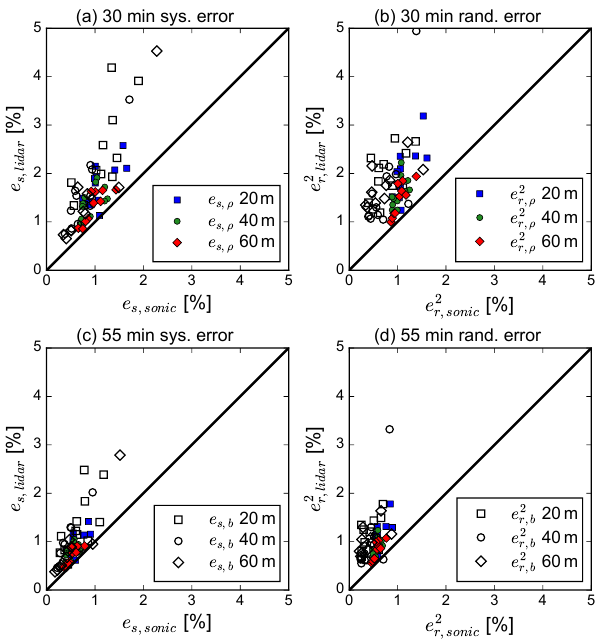
Figure 8. Comparison of systematic errors estimated from sonic data ( e s , sonic ) and from lidar data ( e s , lidar ) in (a) for a sampling du- ration of 30min and (c) a sampling duration of 55min, and compar- (cid:16) (cid:17) e 2 ison of the random error estimated from sonic data and r , sonic (cid:16) (cid:17) e 2 from lidar data in (b) for a sampling duration of 30min r , lidar and (d) a sampling duration of 55min. The method used to esti- mate the errors is indicated by the subscript in the legend, where ρ denotes the M ρ method using the autocorrelation function and b denotes the M b method using the stationary bootstrap method. The solid lines are the 1:1